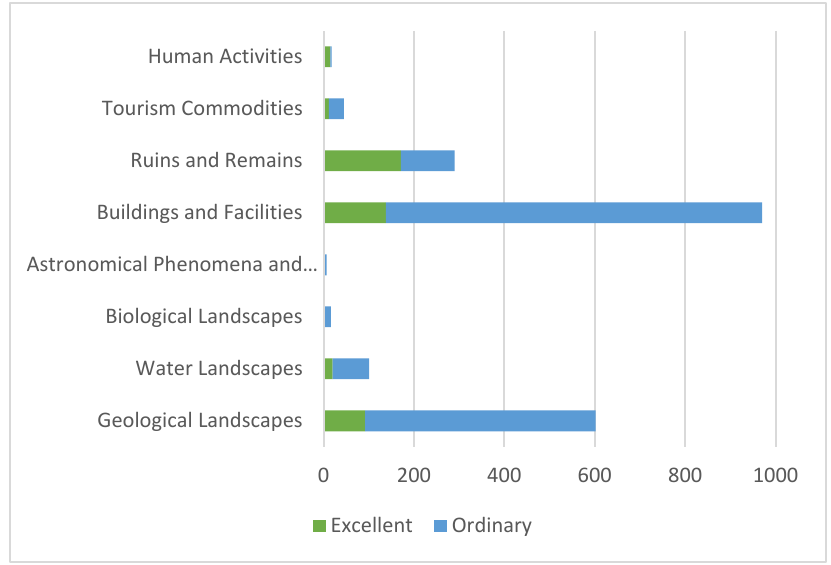
Figure 3. Distribution of different levels of tourism resources according to the main types. Table 2. Grade distribution of tourism resources in Longde County.